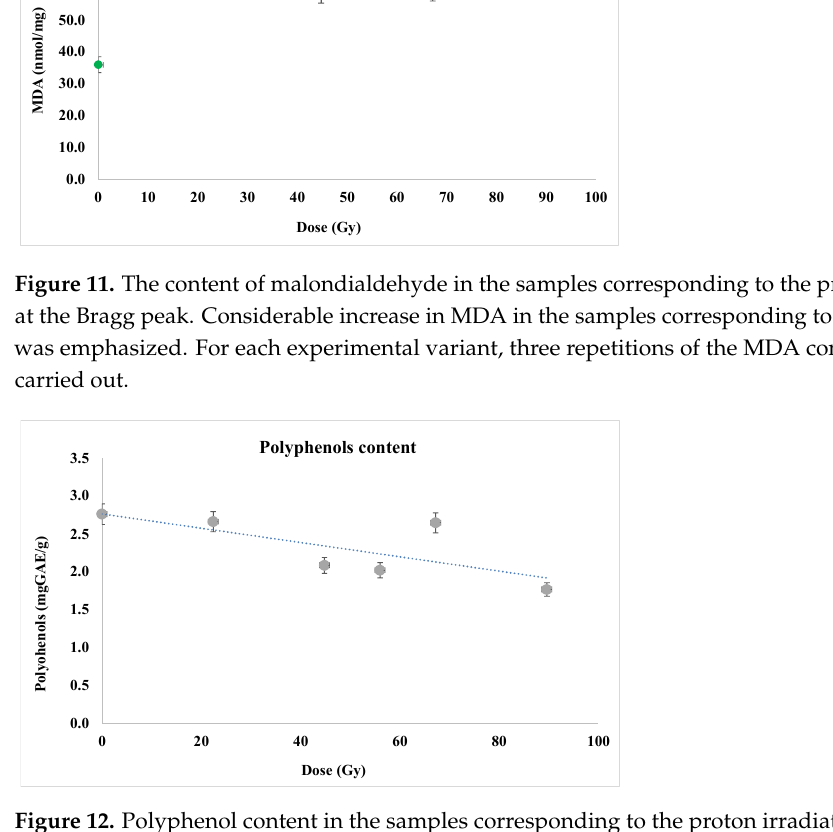
Figure 12. Polyphenol content in the samples corresponding to the proton irradiation at the Bragg peak. Linear dose-response was found with positive variations of the polyphenol content. For each experimental variant, three repetitions of polyphenol content assay were carried out.